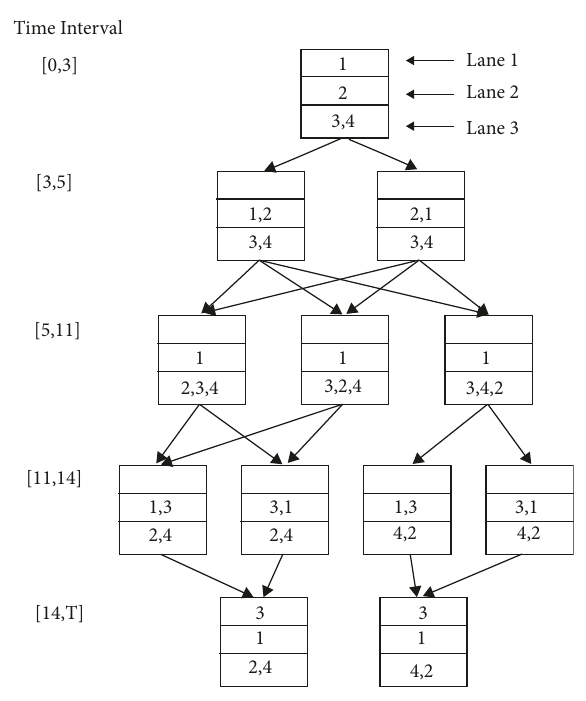
Figure 2: Demonstration example of order states on